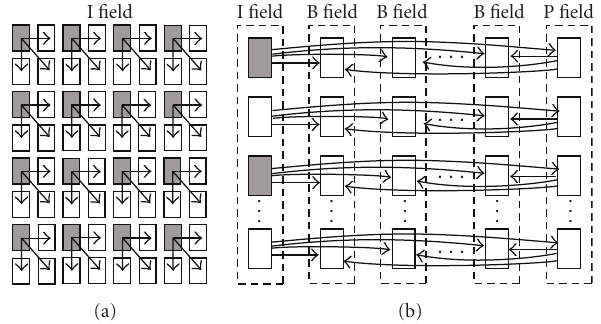
Figure 5: Prediction structure for the multiview data compression: (a) the spatial prediction structure inner I field, and (b) temporal prediction